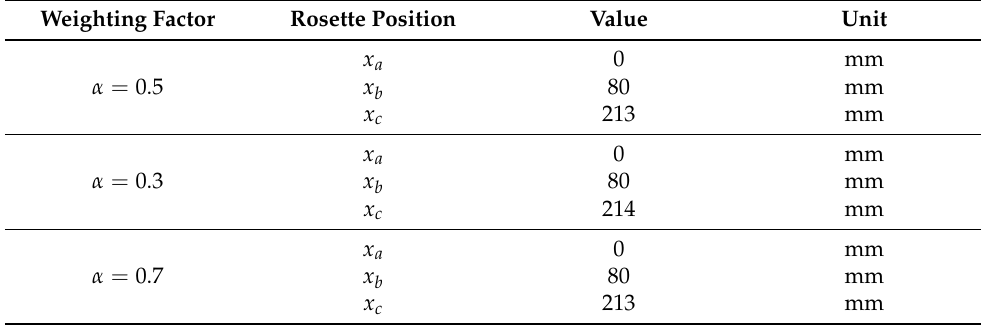
Table 4. Optimal sensor placement: three-rosette